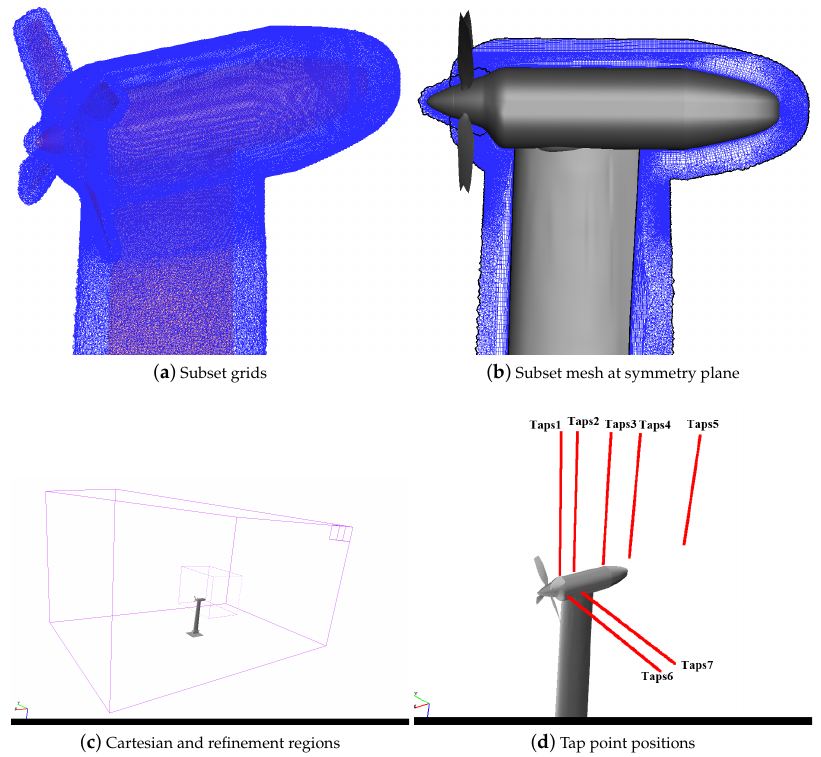
Figure 5. Computational grids for Kestrel-SAMAir simulations with shown tap point